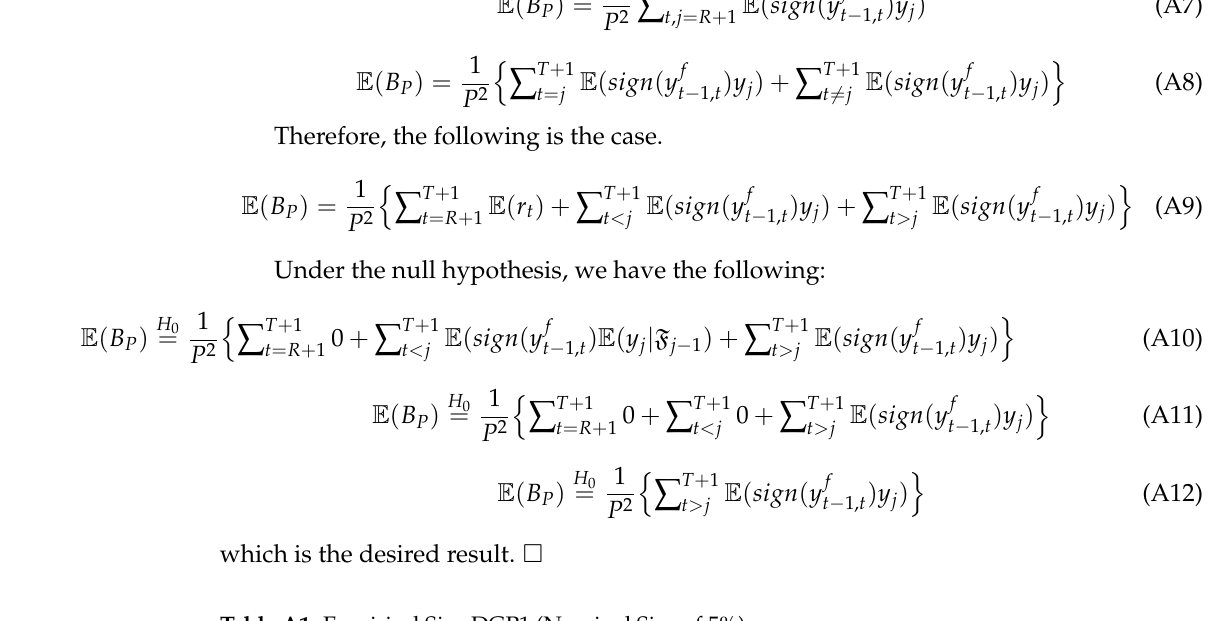
Table A1. Empirical Size DGP1 (Nominal Size of